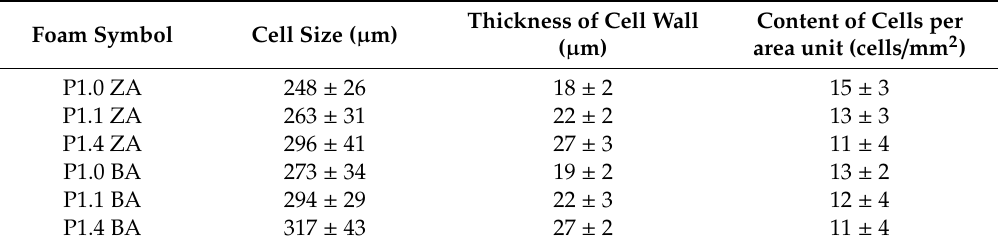
Figure 5. Micrographs of cellular structure of foam with 0, 0.1, and 0.4 Eq of bio-polyol in 150x (ZA series on the top, BA series bottom). Table 4. Results of SEM micrographs analysis.